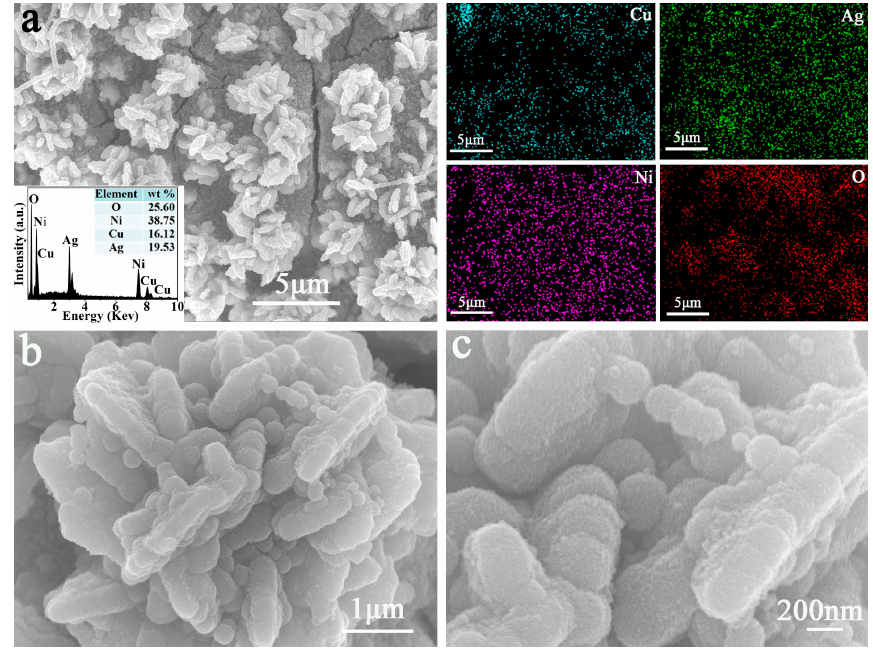
Figure 2. FE-SEM images of the Ag@Ni(OH) 2 composite with 30 s the deposition time of Ni(OH) 2 : ( a ) Low magnification image and the EDS element mapping, inset is the EDS spectrum; ( b – c ) high magnification images.